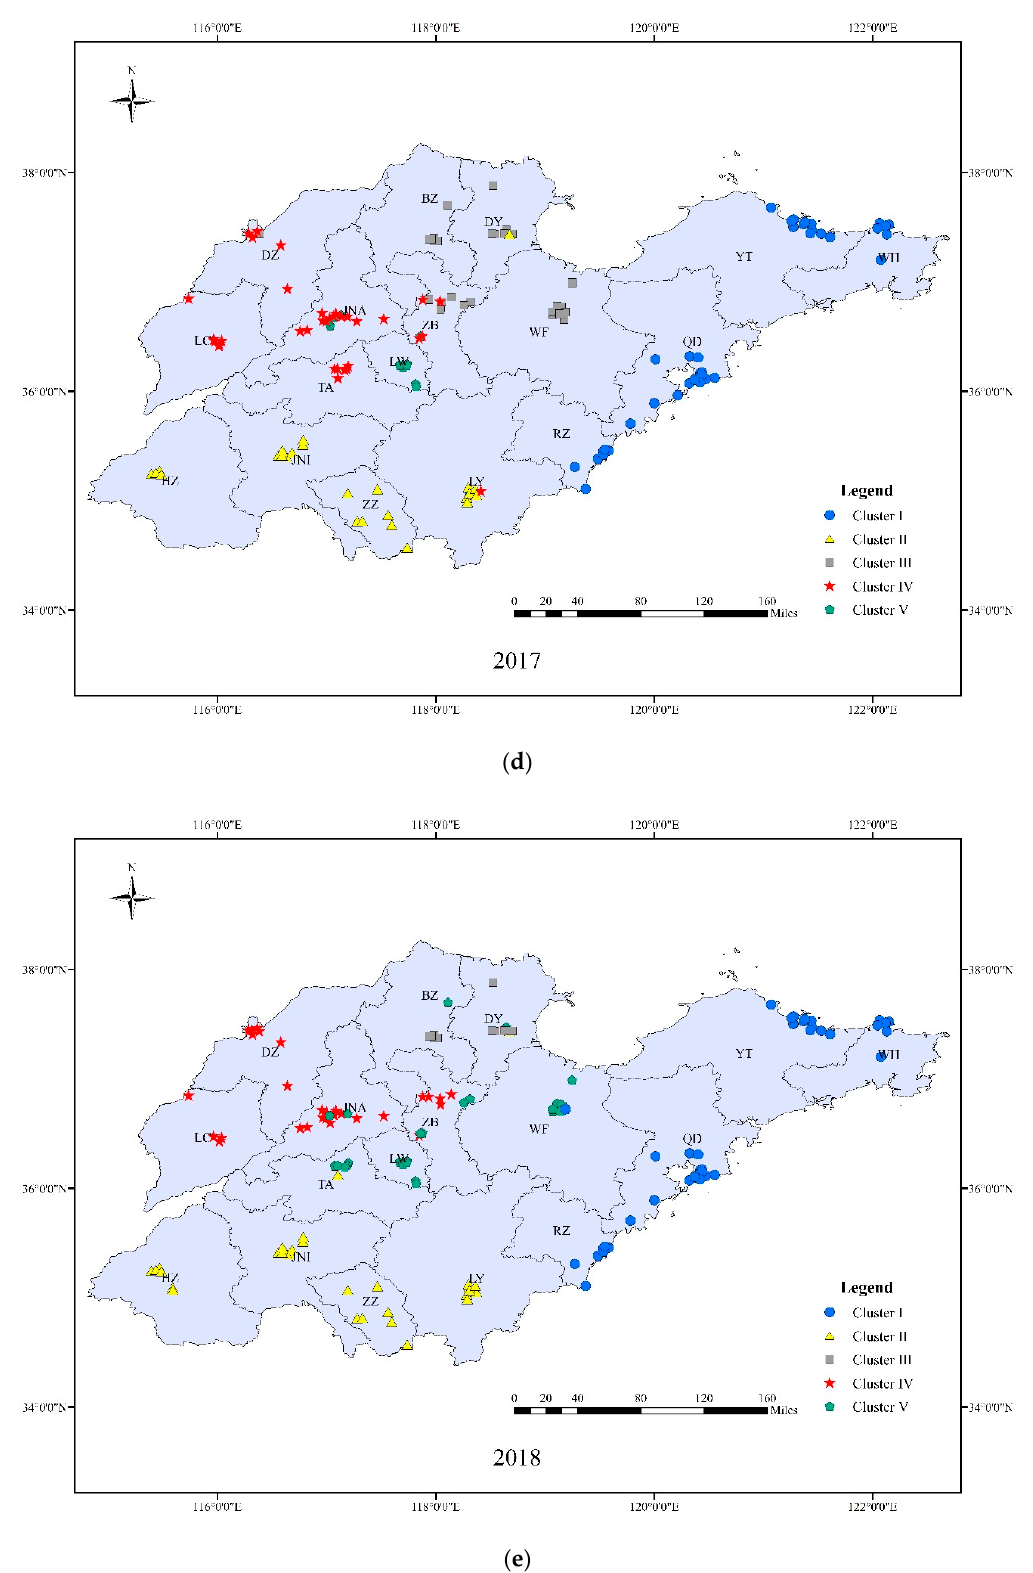
Figure 6. Cluster analysis of ozone concentrations in 17 Prefectural level cities of Shandong province in 2014-2018. Five clusters were obtained including Peninsula Coastal area (PC), Lunan inland area (LN), Western Bohai area (WB), Luxi plain area (LX) and Luzhong mountain area (LZ) (( a ) 2014; ( b ) 2015; ( c ) 2016; ( d ) 2017; ( e )